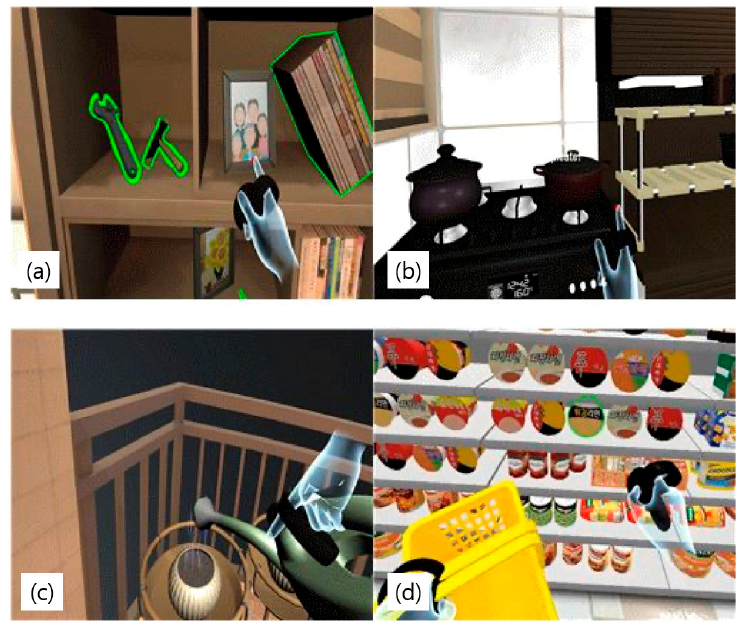
Figure 2. Components of the virtual reality system. ( a ) living room, ( b ) kitchen, ( c ) veranda, ( d ) convenience store.